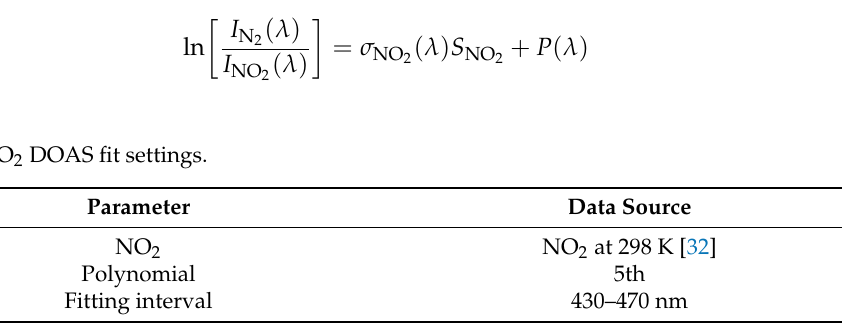
Table 2. NO 2 DOAS fit settings.